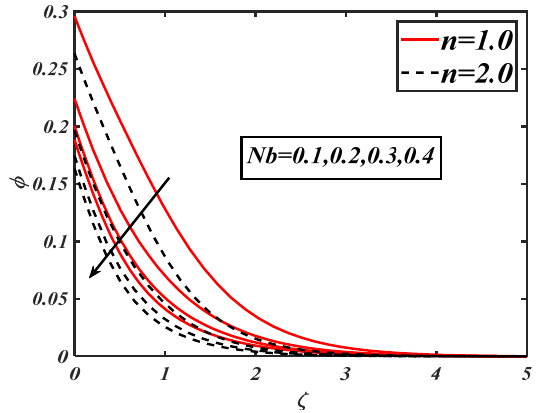
Figure 15. Nb illustration against φ .